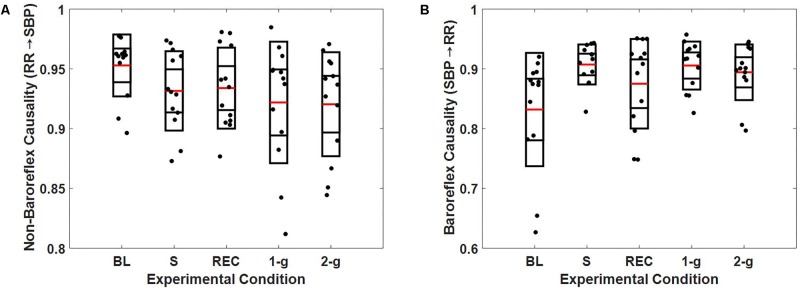
Boxplot representation of non-baroreflex (A) and baroreflex (B) causalities in response to baseline (BL), stand (S), recovery (REC), 1-g, and 2-g experimental protocol.